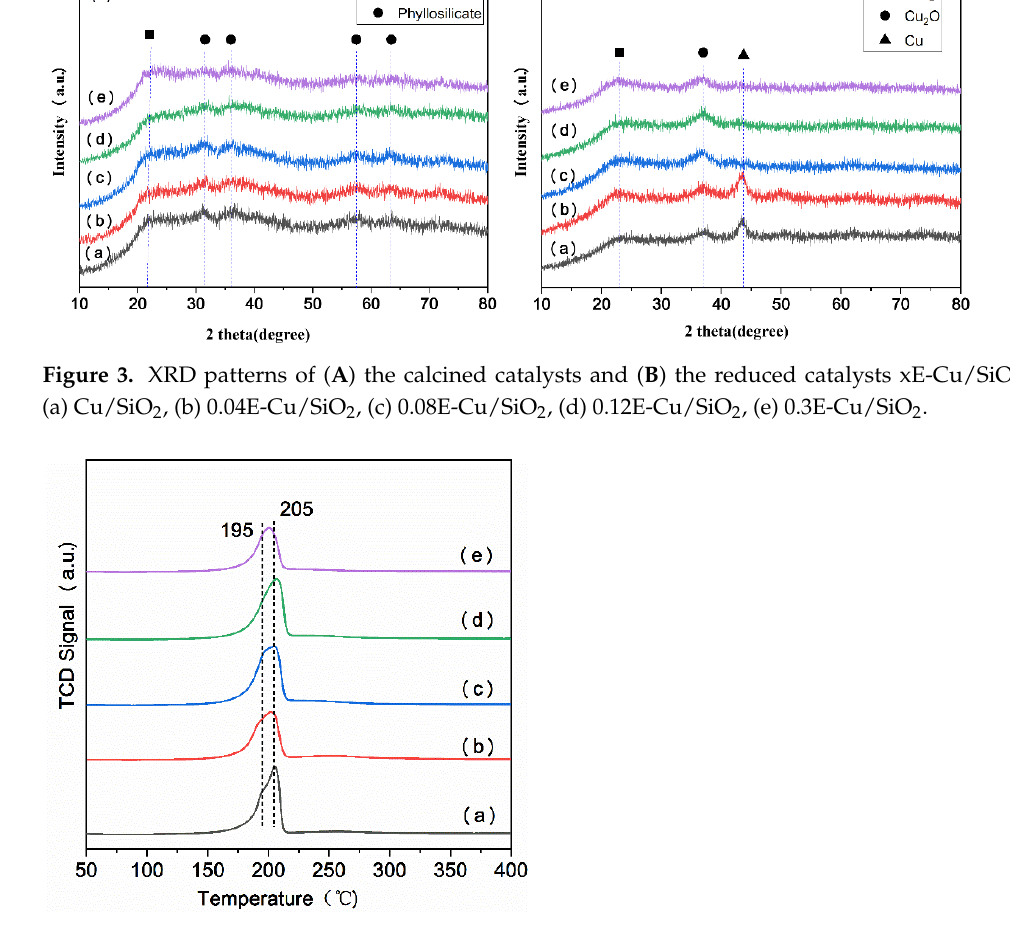
Figure 3. XRD patterns of ( A ) the calcined catalysts and ( B ) the reduced catalysts xE-Cu – SiO 2 . (a) Cu/SiO 2 , (b) 0.04E-Cu/SiO 2 , (c) 0.08E-Cu/SiO 2 , (d) 0.12E-Cu/SiO 2 , (e) 0.3E-Cu/ SiO 2 .